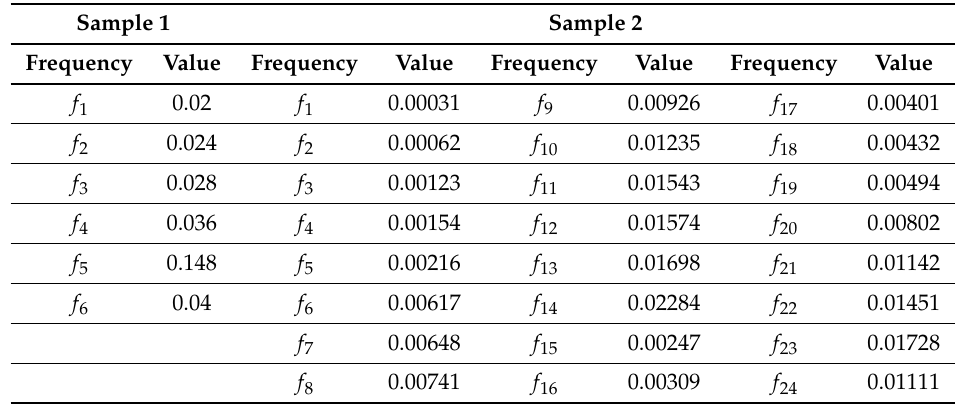
Table A2. Significant frequencies of T series in Hertz.